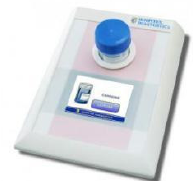
Figure 1. Example of nephelometer. Electronics 2020 , 9 , x FOR PEER REVIEW